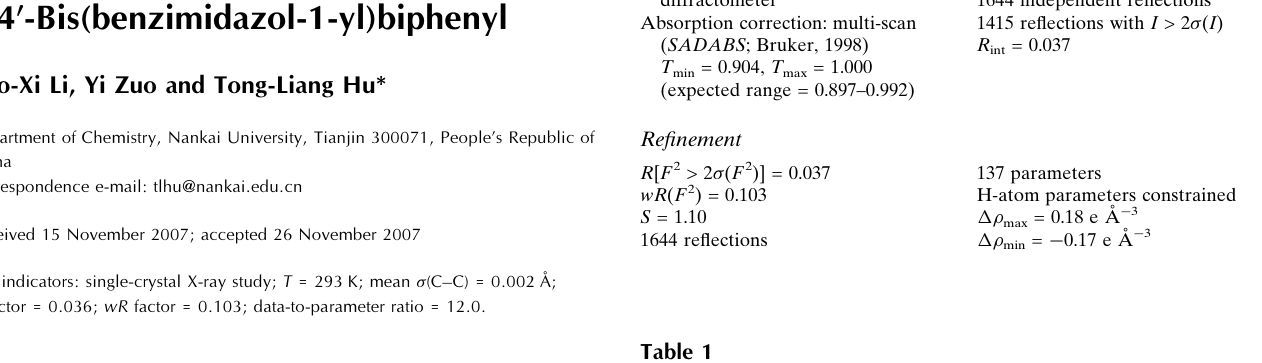
Hydrogen-bond geometry (A˚ , (cid:1)